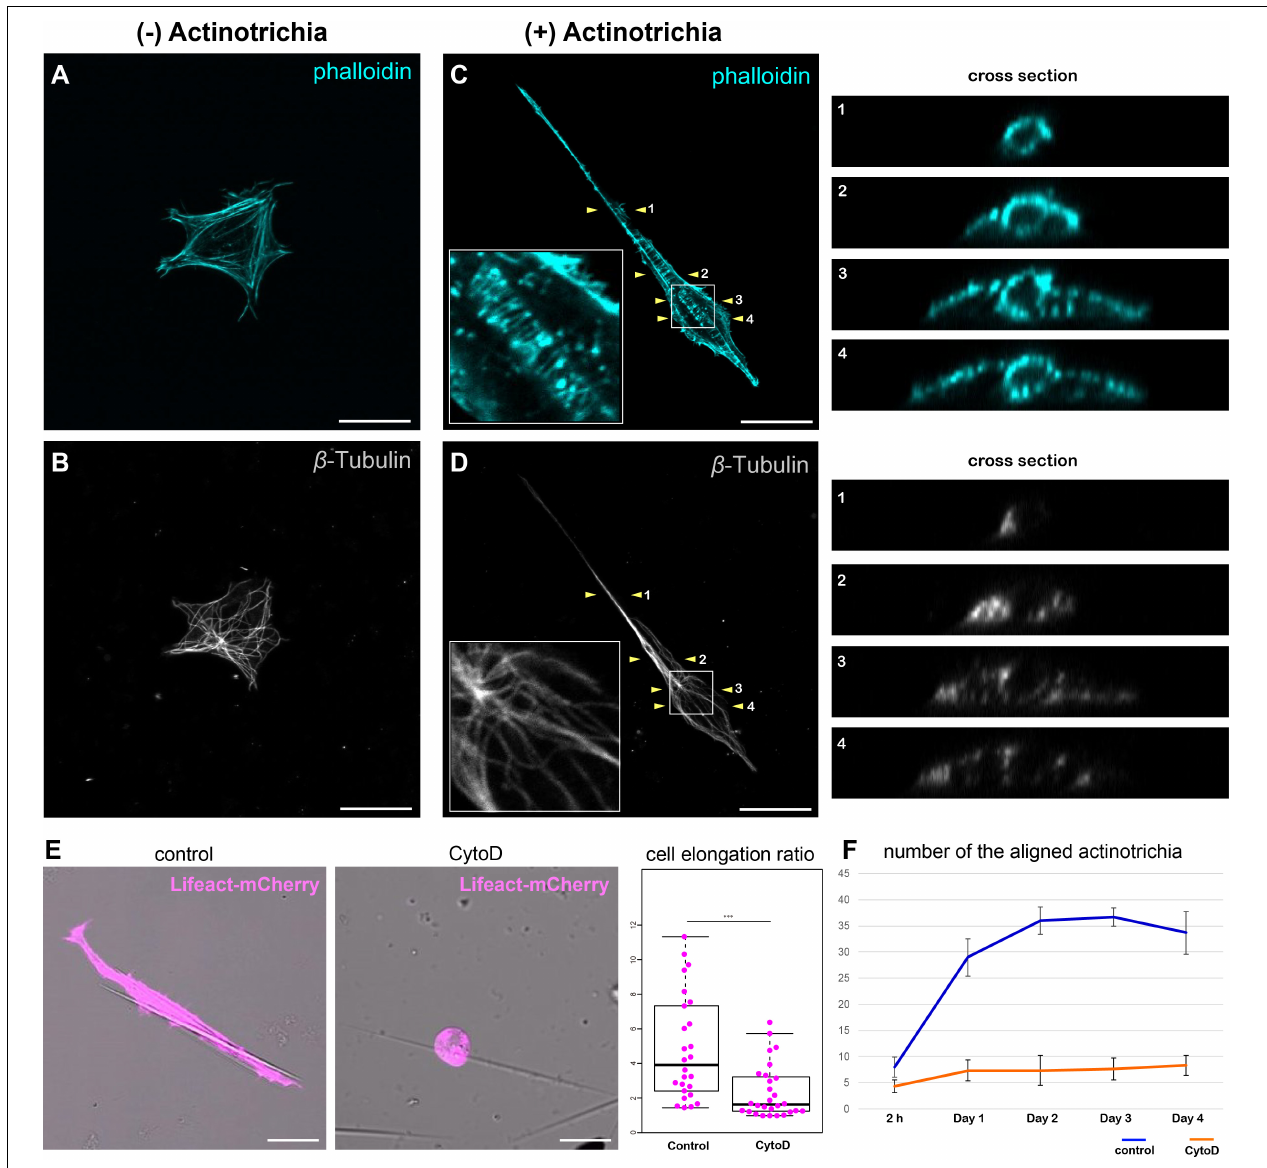
FIGURE 6 | Inhibition of actin polymerization suppressed the orientation formation of actinotrichia. (A,B) A cultured mesenchymal cell without contact with actinotrichia was stained with phalloidin and anti- β -Tubulin antibodies. (A) Image of phalloidin staining and (B) anti- β -Tubulin antibody staining. Actin-rich fibers were detected below the plasma membrane and actin-rich filopodia structures were developed at the cell edge (A) . β -Tubulin localization was observed radially from the center of the cell (B) . (C,D) A cultured mesenchymal cell in contact with a single actinotrichia was stained with phalloidin and anti- β -Tubulin antibodies. The ortho-slice images between two yellow arrowheads are showed in the right panels and the magnified images of the white box are inset. (C) The image of phalloidin staining and (D) anti- β -Tubulin antibody staining. Strong accumulation of actin was detected around the actinotrichia. On the contrary, β -Tubulin localization was observed radially from the center of the cell and was not detected around the actinotrichia. (E) The morphology of the cultured mesenchymal cells at day 2 after culture under control and CytoD-treated conditions. The mesenchymal cells treated with CytoD tended to be unable to elongate along the actinotrichia axis. The elongation ratio of the CytoD treated cells is much lower than that of the control cells. (F) The number of aligned actinotrichia did not increased under the CytoD-treated condition. P -values: *** P < 0.001. Scale bars: 20 µ